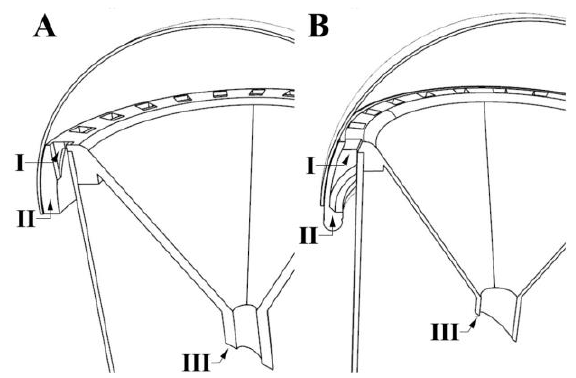
Figure 3. Diagram showing the differences between cylinder traps 1 (panel ( A )) and 2 (panel ( B )). I. Funnel rim with 24 equidistant entry holes; in trap 2, they are at a 35 – 45° angle. II. The funnel rim has an extra ledge in trap 2. III. The thickness of the plastic material used to print the funnel is 3 mm in trap 1 and 1.5 in trap 2. The opening of the funnel leads to a capture